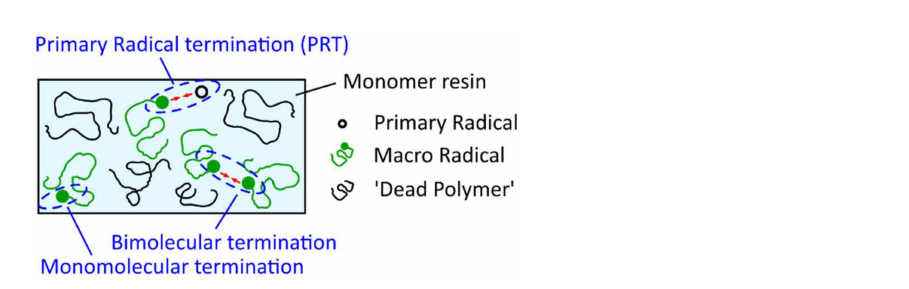
Figure 21. Termination mechanisms considered in the kinetic model of Christmann et al.